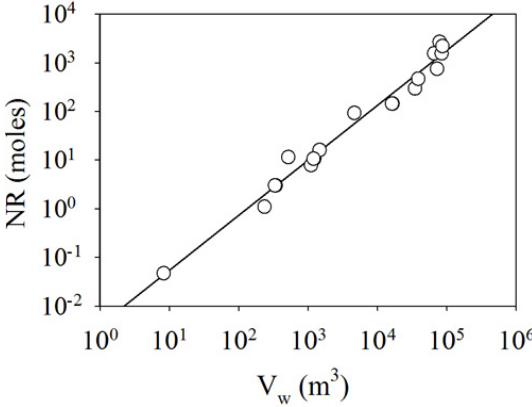
Fig. 7. Relationship between net nitrate retention over a tidal cycle and water volume. Data are reported for the three sampling sites for various tides in 2008, 2010, and 2011. Nitrate retention is a simple function of hydrologic flux that varies over 5 orders of magnitude. Seasonal multi-year data for spring (high tides) follow the relation- ship: NR = 0 . 0045 V 1 . 1 ( n = 13, R 2 = 0 . 98).